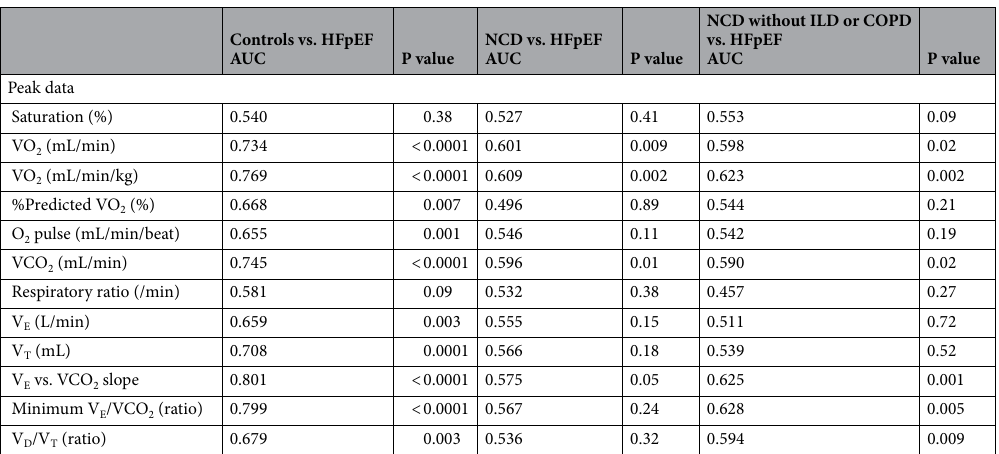
Table 4. Diagnostic accuracy of expired gas data. ILD, interstitial lung disease; COPD, chronic obstructive pulmonary disease; and other abbreviations as in Tables 1 and 2.